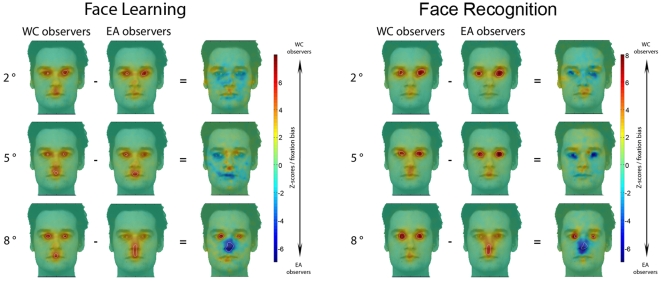
Fixation maps of Western Caucasian (WC) and East Asian (EA) observers for each Spotlight condition during WC and EA face learning (left) and recognition (right).Fixation biases for WC (red) and EA (blue) observers are highlighted by subtracting WC and the EA Z-scored group fixation maps. Areas fixated above chance are delimited by white borders. Note the shift of eye movement fixations in the EA observers in the 8° Spotlight condition for both tasks.